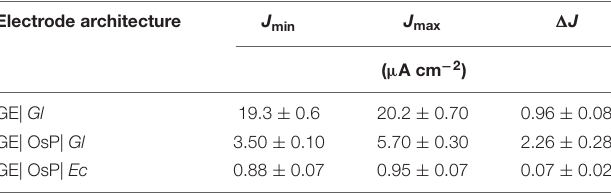
TABLE 2 | Effect of electrode modification on photocurrent density outputs during chronoamperometric tests with electrodes polarized at 0.4 V vs Ag| AgCl| KCl 3.5